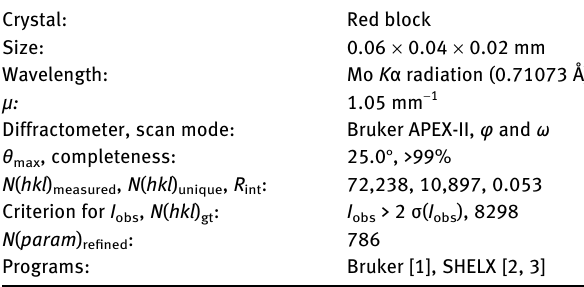
Table  : Data collection and